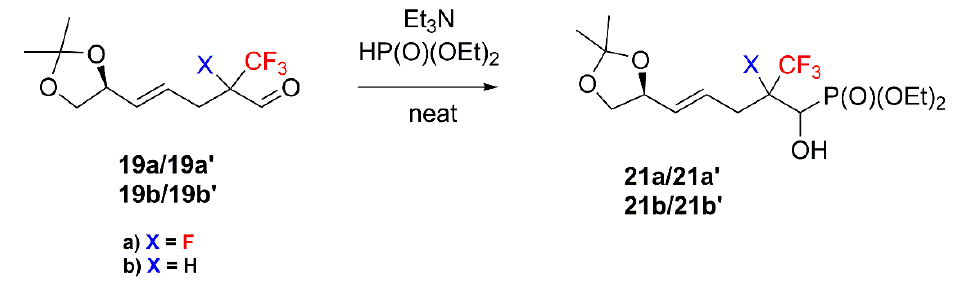
Table 1. Values of known experimental pK a , calculated pK a and calculated pK a with included obtained for Equation (1) parameters A and B.